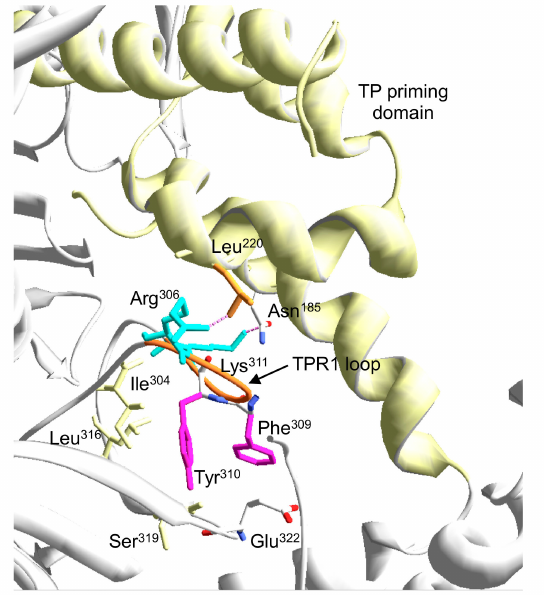
Figure 10. Detailed view of the interaction of TPR1 loop residues with the TP priming domain. The electropositive and aromatic residues of the TPR1 loop studied here are shown in cyan and magenta sticks, respectively. Flexible TPR1 loop regions (residues 305–315) are colored in orange. Terminal protein priming domain is shown in ribbon representation (colored in yellow). For details, see main text.